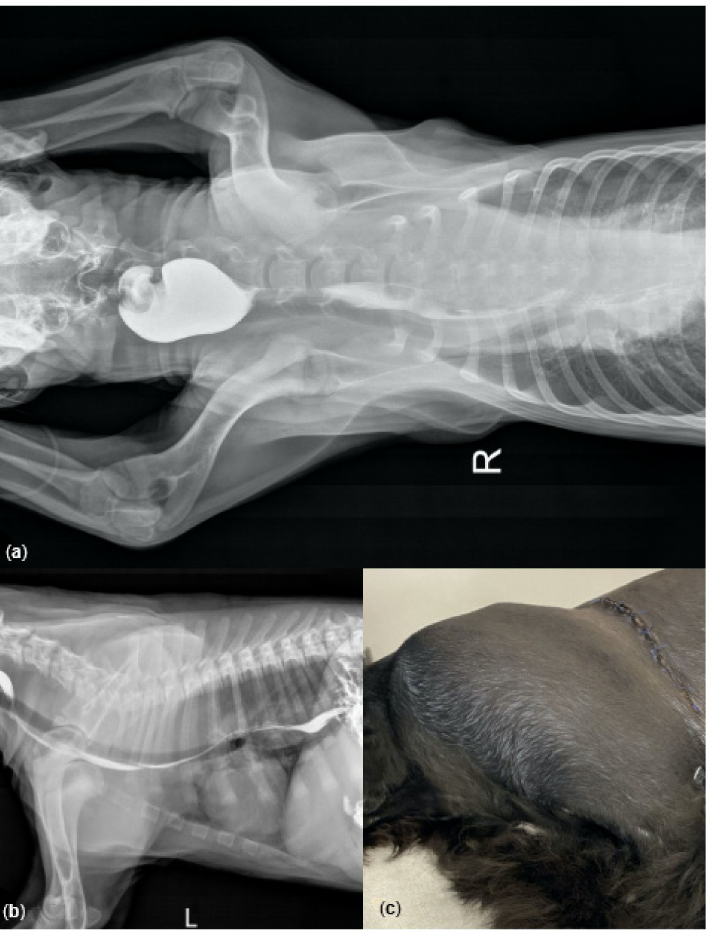
Figure 1. Clinical features showing chest radiographs and hematomas in a Newfoundland–Parti Standard Poodle hybrid puppy with hemophilia B: Case #1. Radiographic views of ventrodorsal ( a ) and lateral ( b ) thorax after a bolus of barium suspension showing tracheal and esophageal displacement at the time of admission (Day 1). Photograph of left chest wall post-surgery on Day 10 showing a large subcutaneous hematoma ( c